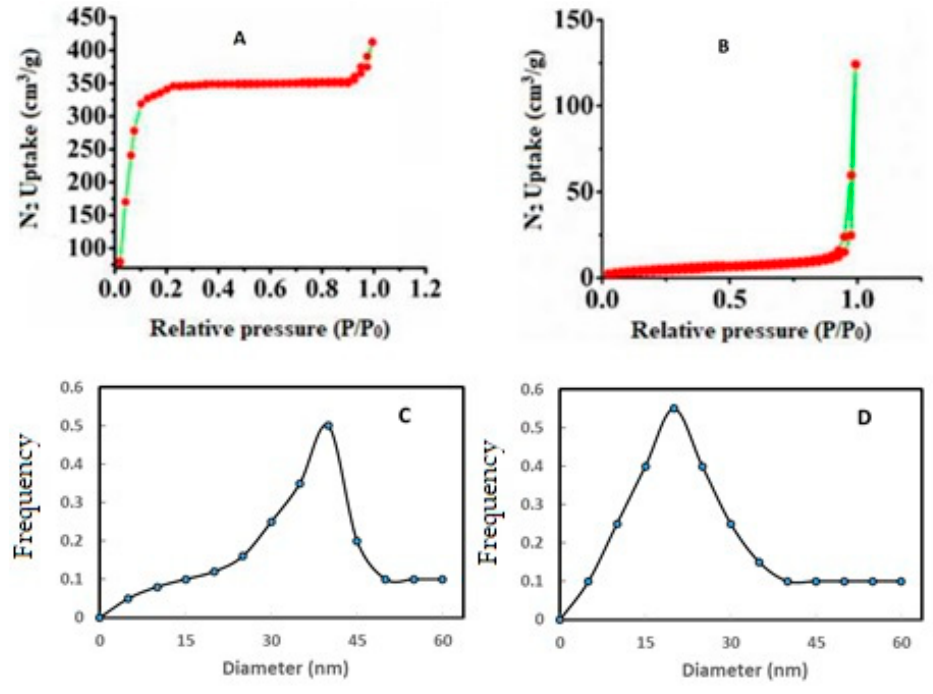
Figure 4. N 2 adsorption–desorption isotherm at 77.35 K, of ( A ) Zn-BTC, ( B ) Zn-BTC@CS and particle size distribution of ( C ) Zn-BTC, ( D ) Zn-BTC@CS.